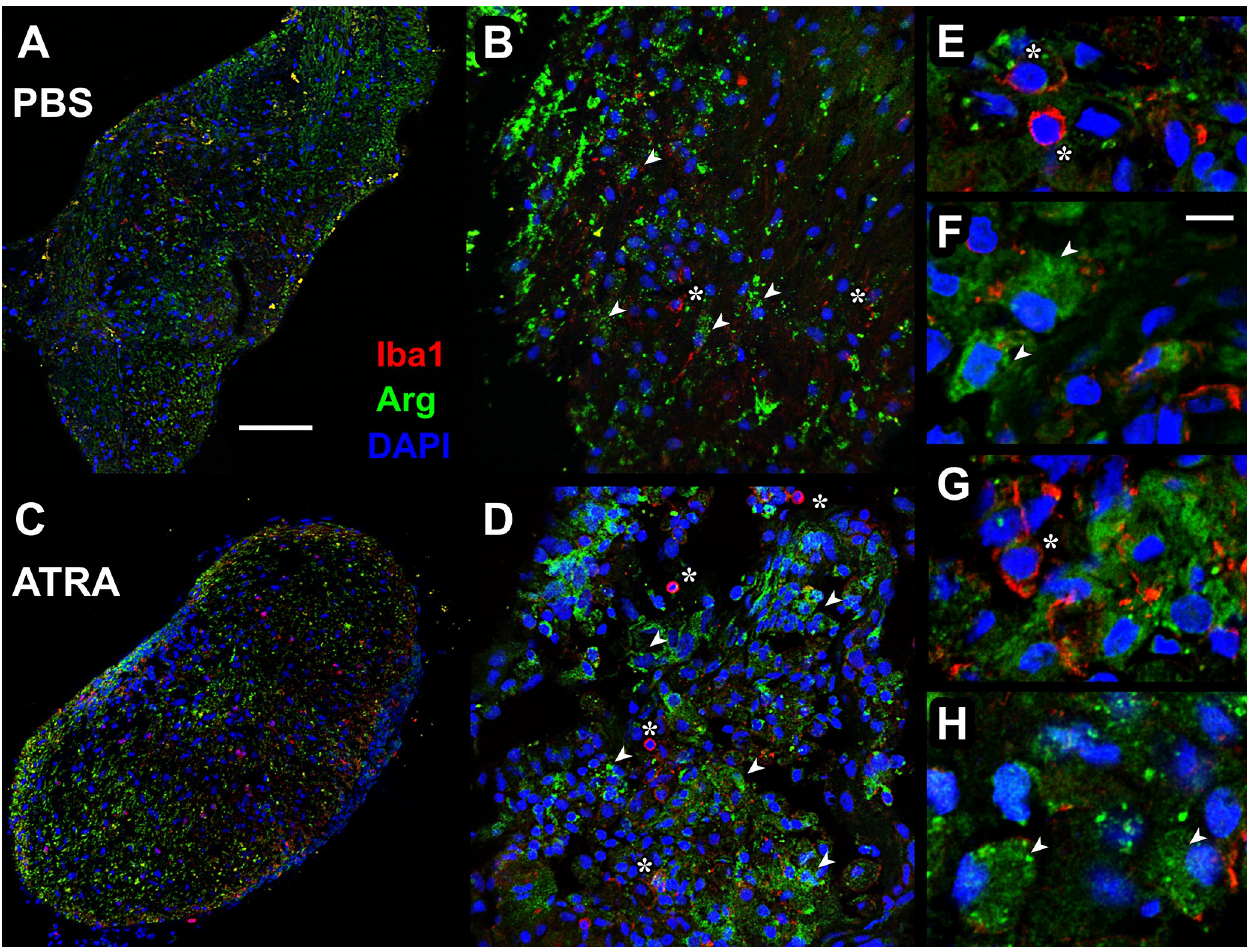
Fig 3. ATRA treatment increases microglia at 1 week. (A—D) Confocal fluorescence micrographs of frozen sections of optic nerve 1 week after axotomy, immunostained with Arg1 (macrophages: Green) and Iba1 (microglia: Red) antibodies. Nuclei are counterstained with DAPI (blue). (A and C) PBS treatment, (B and D) ATRA treatment, showing increased numbers of Iba1-labeled microglia. (B and D) Higher magnification views with some macrophages (arrowheads) and microglia (asterisks) indicated. Scale bar in A: 100 μ m in A and C; 50 μ m in B and D.